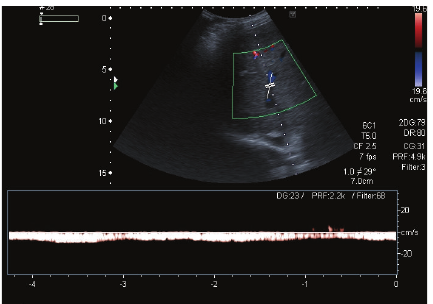
Figure 15: Spectral Doppler image in a patient with BCS shows monophasic waveform in the hepatic